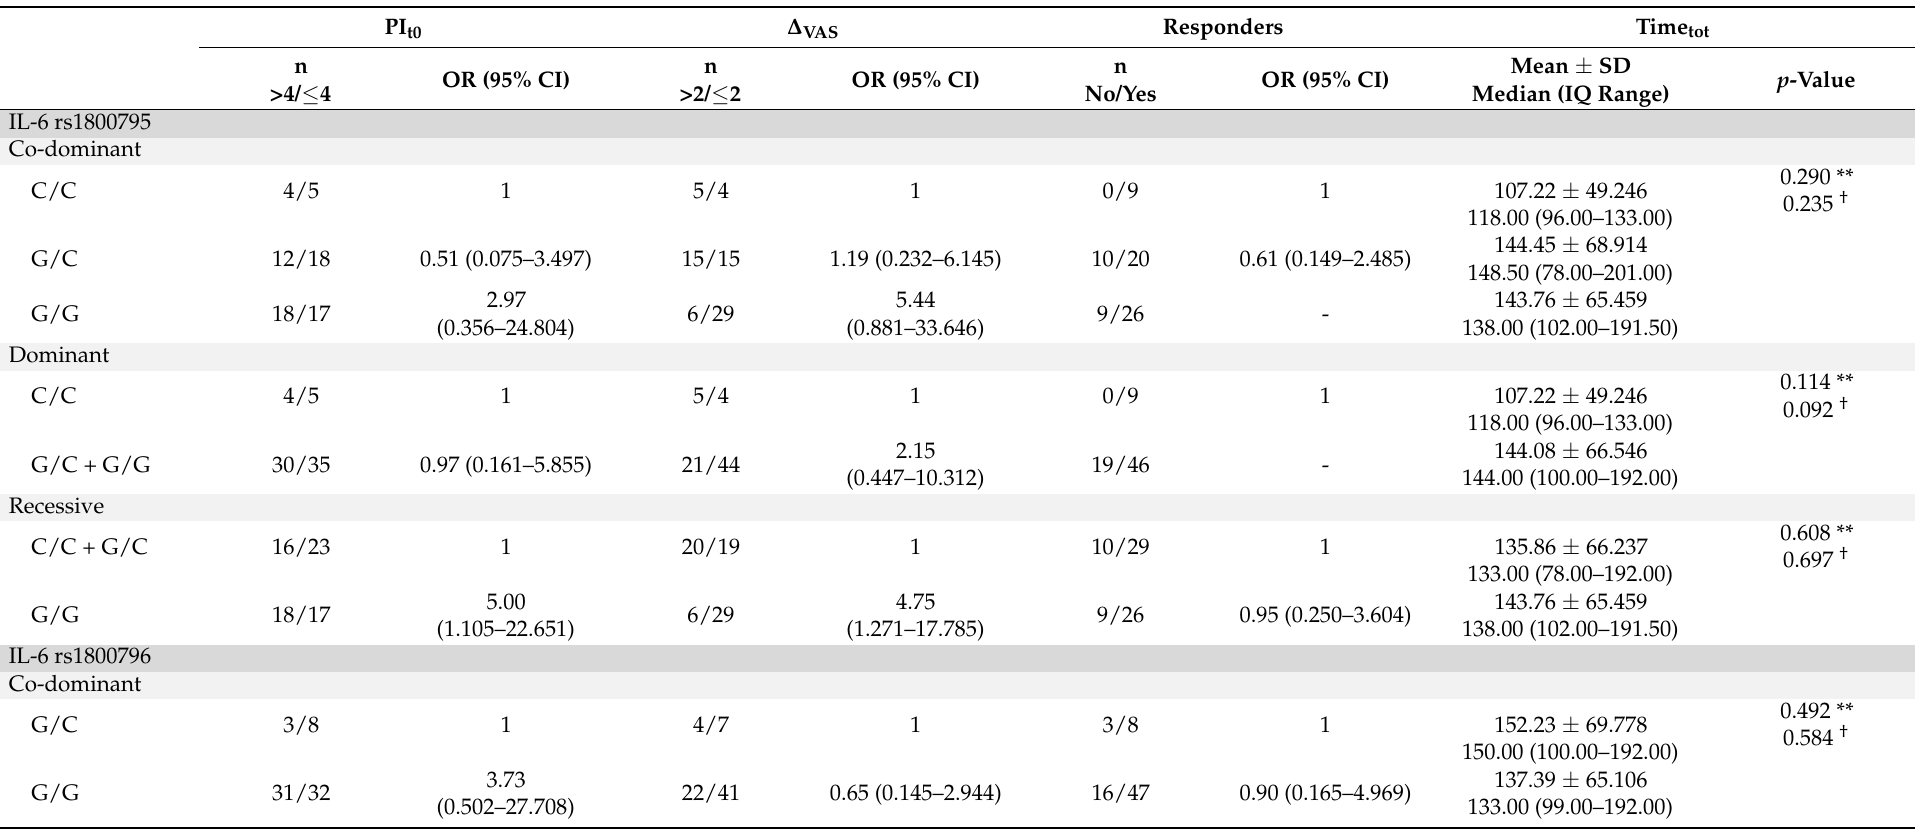
Table 5. Association between genetic factors and pain intensity (PI) outcomes before and after opioid